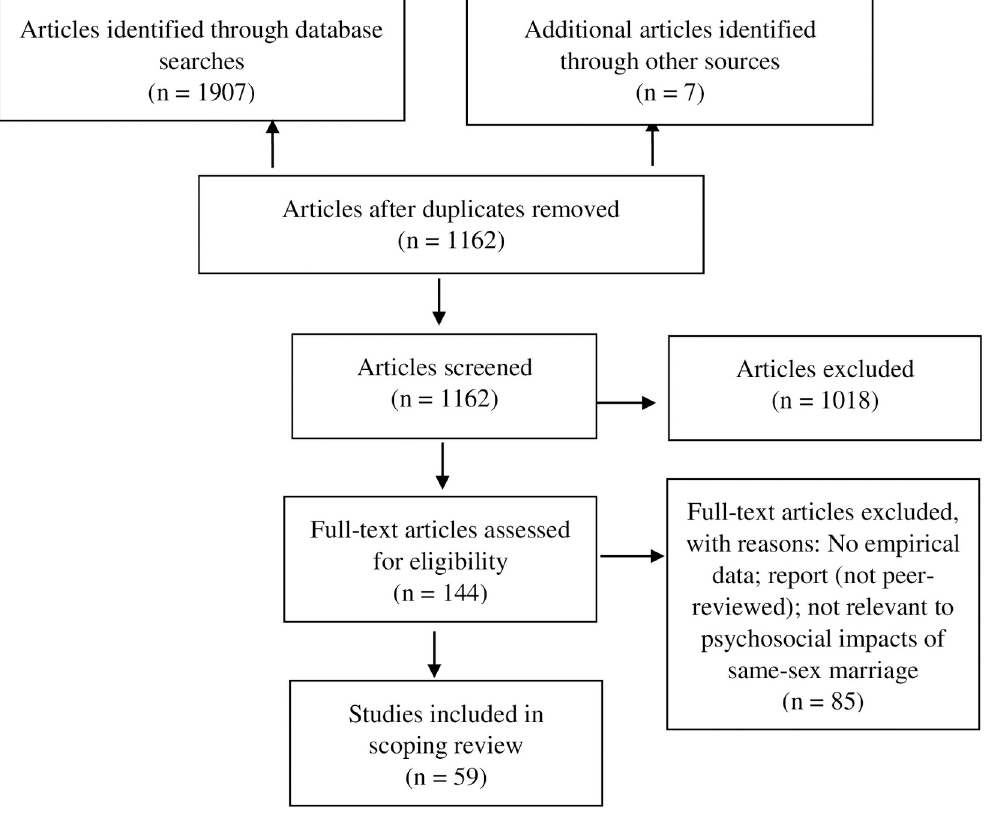
Fig 2. Studies identified and included in the literature